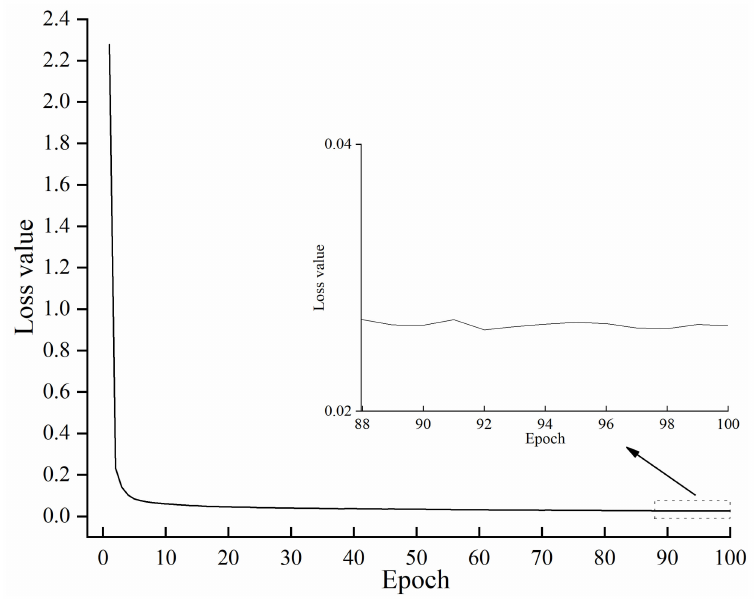
Figure 7. Variation of loss value with training